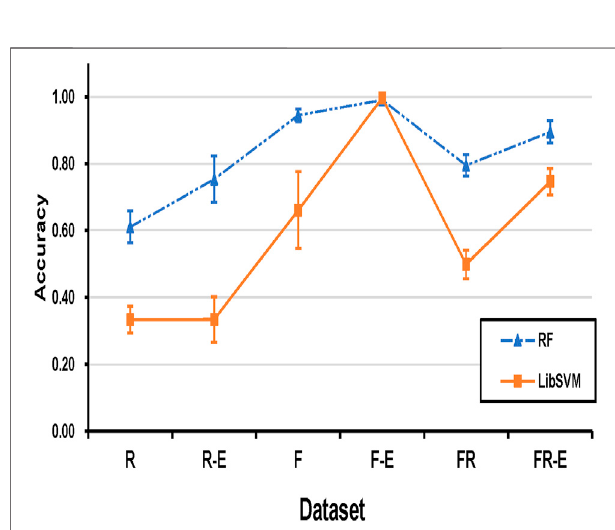
FIGURE 9 | 10-fold cross-validation accuracy with different datasets, including real data (R) , fake data (F) , real data after equalization (R-E) , fake data after equalization (F-E) , the mixture of fake data and real data (FR) , the mixture of fake data and real data after equalization (FR-E)